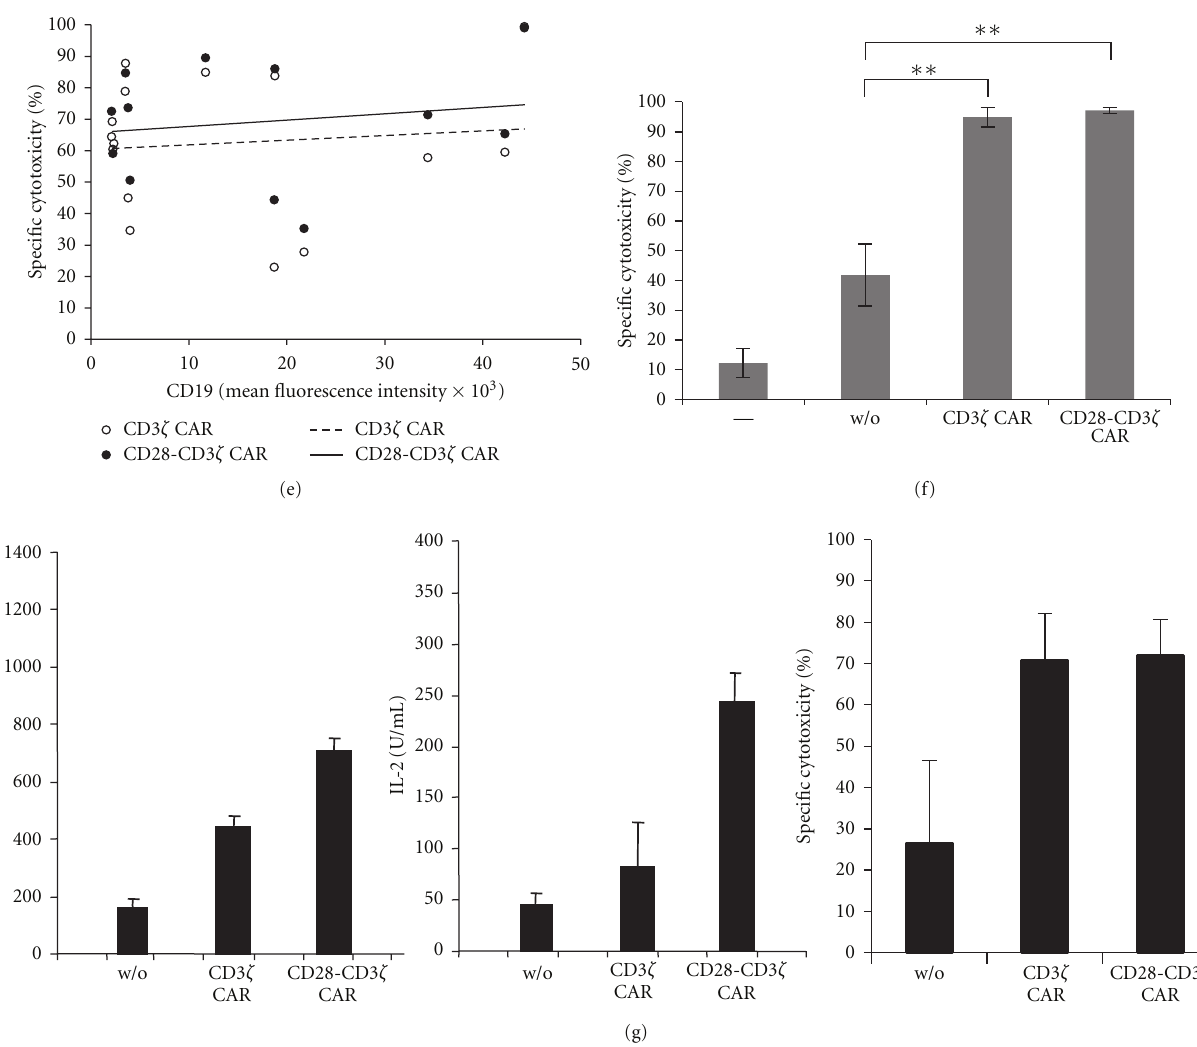
Figure 1: Anti-CD19 CAR redirects engineered T-cells towards CD19 + B-CLL cells. (a) Schematic diagram depicting the modular composition of the recombinant CD19-specific chimeric antigen receptor (CAR). scFv: single chain fragment of variable region